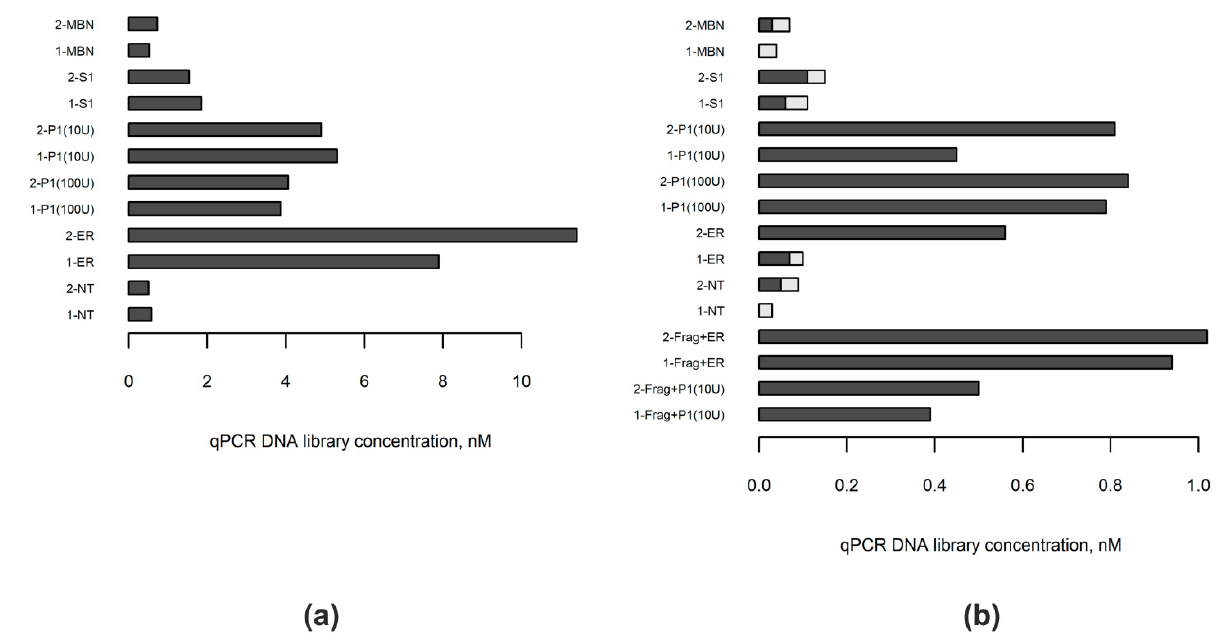
Figure 2. Concentrations of libraries prepared from blood ( n = 2) and FFPE-derived ( n = 2) DNA samples with different enzymes utilized to repair DNA ends. ( a ) Separate aliquots of blood DNA samples 1 and 2 were enzymatically fragmented, then the ends of the resulting DNA fragments were blunted either with one of the single-strand-specific nucleases (mung bean nuclease, MBN; S1 nuclease, S1; nuclease P1, P1) or by using the standard polymerase-based approach (ER). One aliquot of each DNA sample was left untreated (NT). ( b ) FFPE-derived DNA samples 1 and 2 were treated similarly; however, only two aliquots of each sample were subjected to enzymatic fragmentation (Frag) before proceeding to blunt DNA ends step. The concentration of fragments with successfully ligated adaptors in each library was measured by quantitative real-time PCR (qPCR). The proportions of adapter dimers were calculated on the basis of library fragment size distribution analysis and are indicated in the picture as light grey-colored parts of the bars.